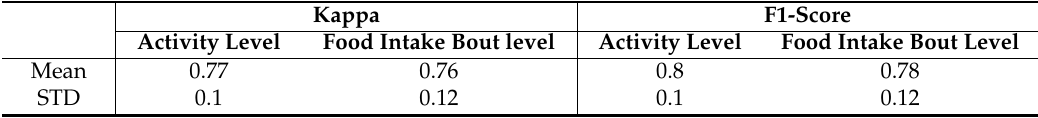
Table 3. Comparison of food intake detection between video based human annotation and AIM predictions based on leave-one-out cross validation.